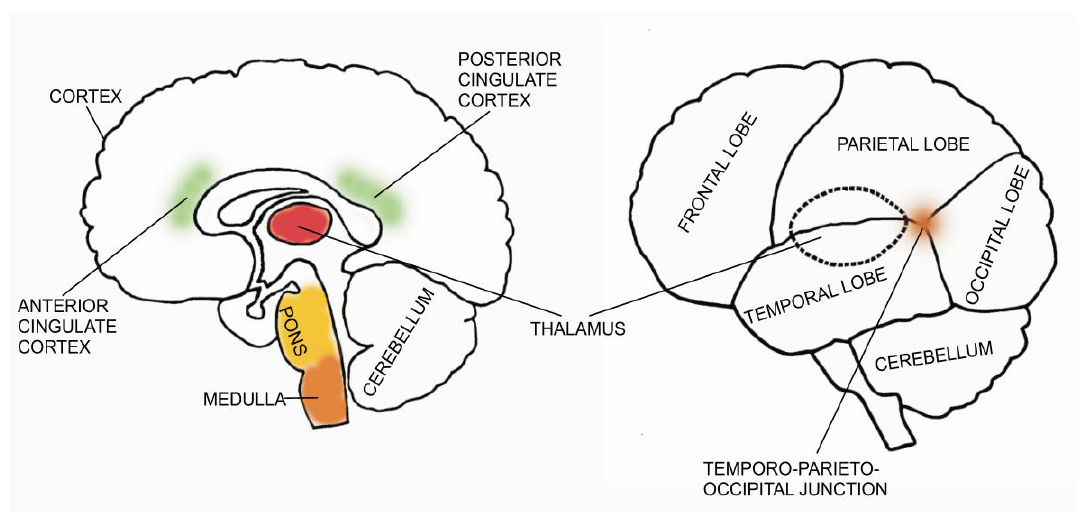
Figure 2. Key regions (shaded in colour) in the central nervous system that contribute to the state of